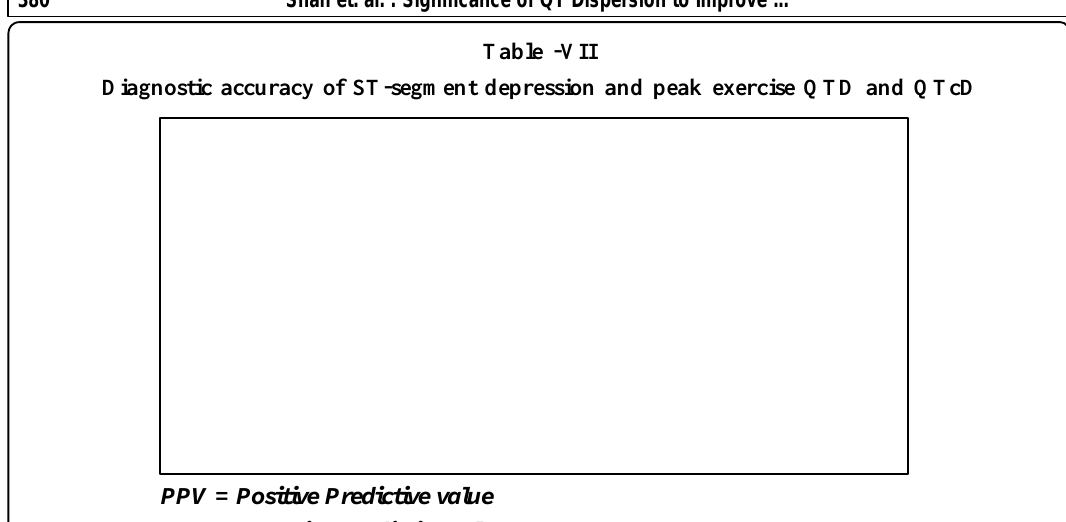
Diagnostic accuracy of ST-segment depression and peak exercise QTD and